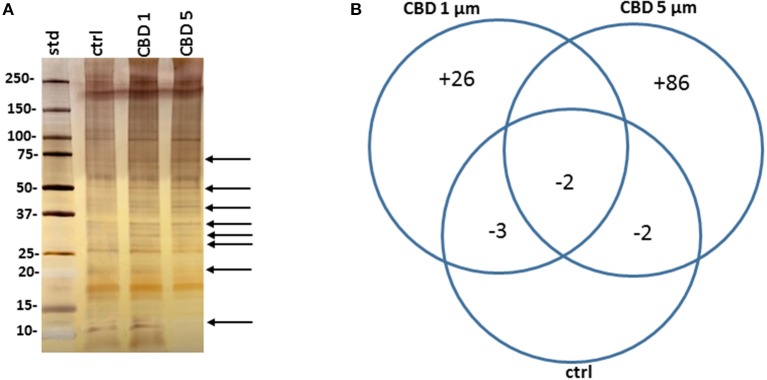
CBD affects protein composition of E. coli VCS257 MVs. (A) A SDS-PAGE silver stained gel reveals banding differences between the CBD treated and non-treated E. coli derived MVs (see arrows highlighting some present and absent bands). (B). Venn diagram showing protein changes in MVs released from CBD treated compared to untreated control E. coli VCS257. Plus (“+”) indicates hits unique to MVs following CBD 1 or 5 μM treatment, respectively; minus (“–“) indicates number of proteins absent in the respective CBD treated MVs, compared to control untreated MVs. For specific protein hits see Tables 1–3.